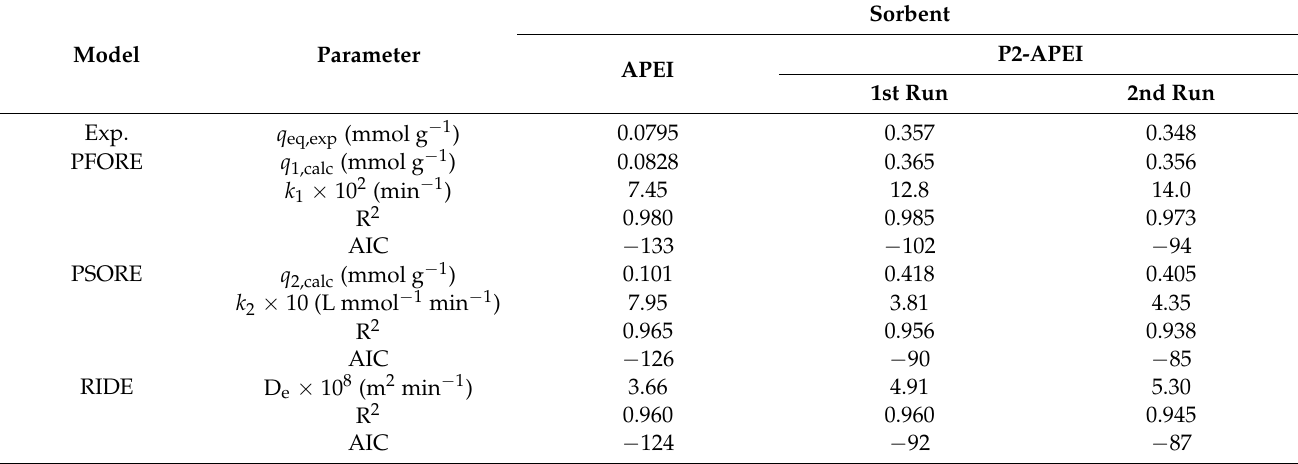
Table 1. Pr(III) uptake kinetics using APEI and P2-APEI sorbents—fitting parameters for the PFORE, PSORE, and RIDE models.